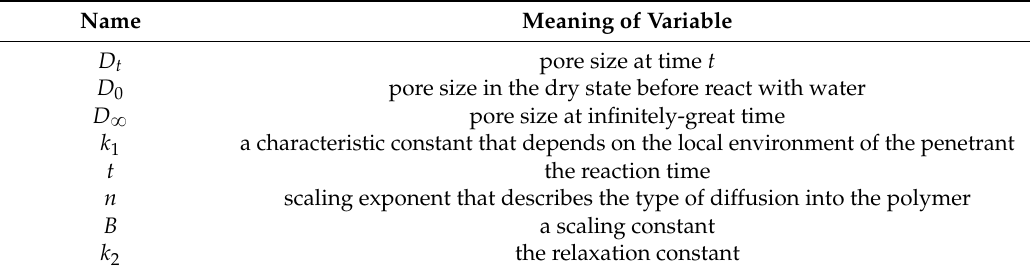
Table 2. The meaning of the variables in Equations (1) and (2).